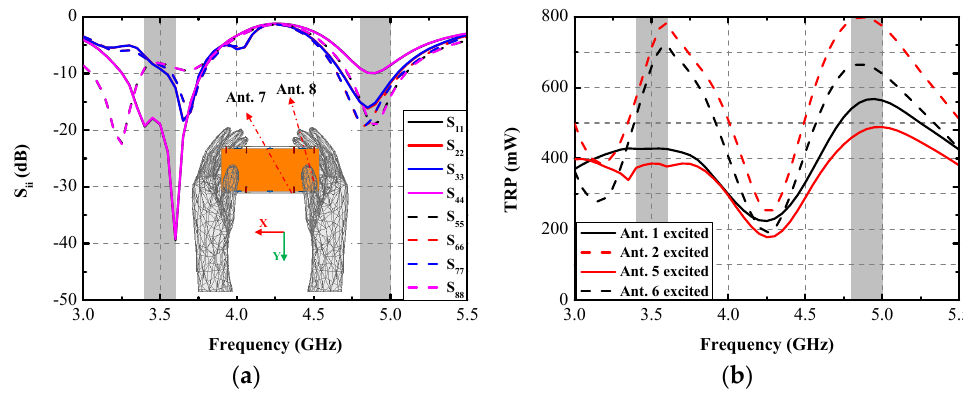
Figure 6. Simulated ( a ) S-parameters and ( b ) TRPs for the presented antenna held in DHM.